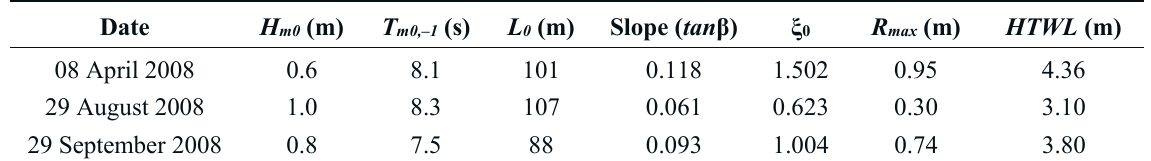
Figure 4. The limit between dry and wet sand (water mark) at the level of high tide deposit (wrack line) shows the level reached by the swash processes ( a ); DGPS measurement of beach/dune profiles and the maximum runup elevation reached during the previous high tide ( b ). Table 1. Overview of environmental conditions and dimensional swash parameters where H m0 (m), T m0 , –1 (s), and L 0 (m) correspond to WW3 offshore wave, R max (m) is runup field measurements, and HTWL (m) is high tide water